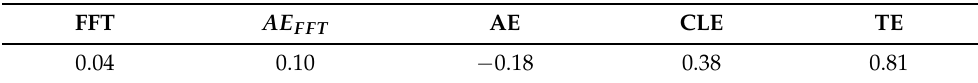
Table 3. Silhoutte score of the class clusters in the feature representation based on the FFT features (FFT), the autoencoder with FFT features ( AE FFT ), the autoencoder (AE), classifier encoder (CLE), and triplet encoder (TE) on T ∪ T p